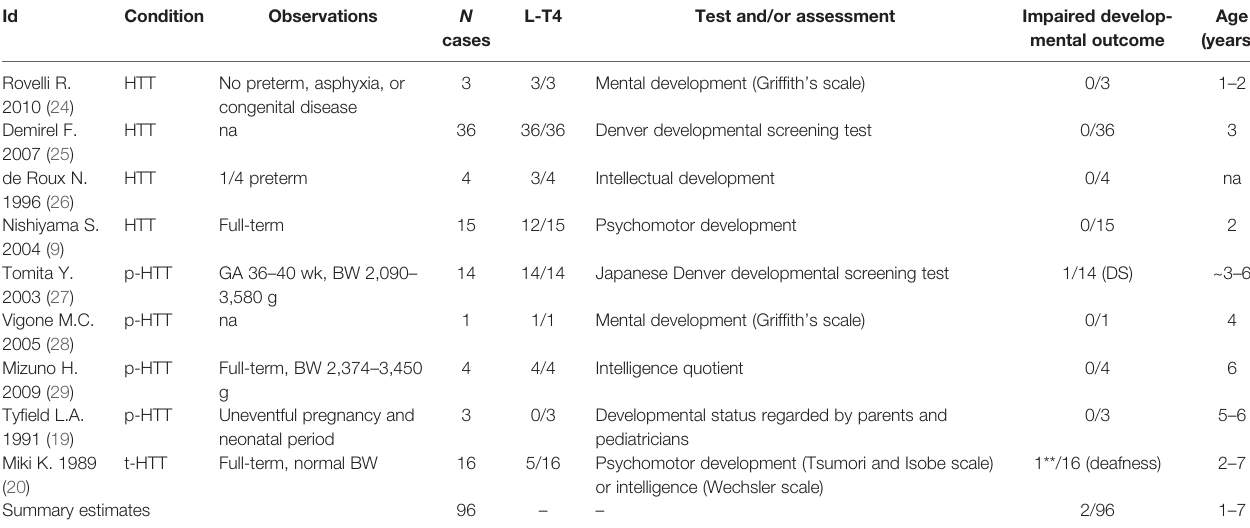
TABLE 2 | Developmental outcome in neonatal hyperthyrotropinemia.